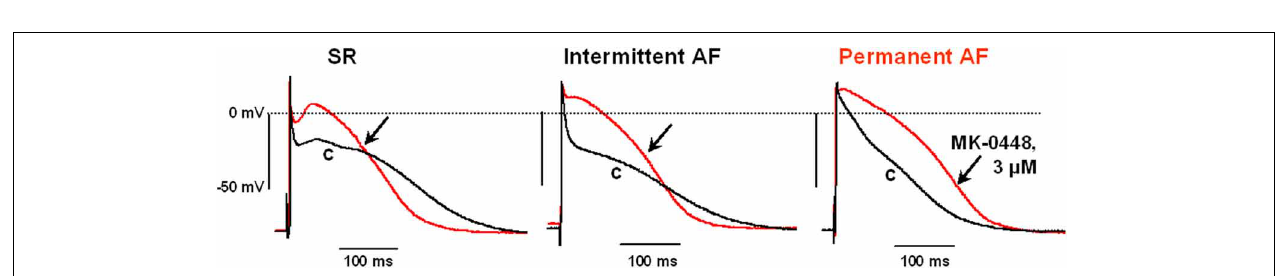
and bottom : Mean values ± s.e.m. from 7 experiments in SR and 5 in AF, of action potential duration at 90, 50, and 20% of repolarization (APD 90 , APD 50 , and APD 20 ) and plateau potential (PLT 20 ). Frequency of stimulation: 1Hz. Please note, that not all preparations were exposed to the full range of concentrations (numbers of preparations indicated in brackets).